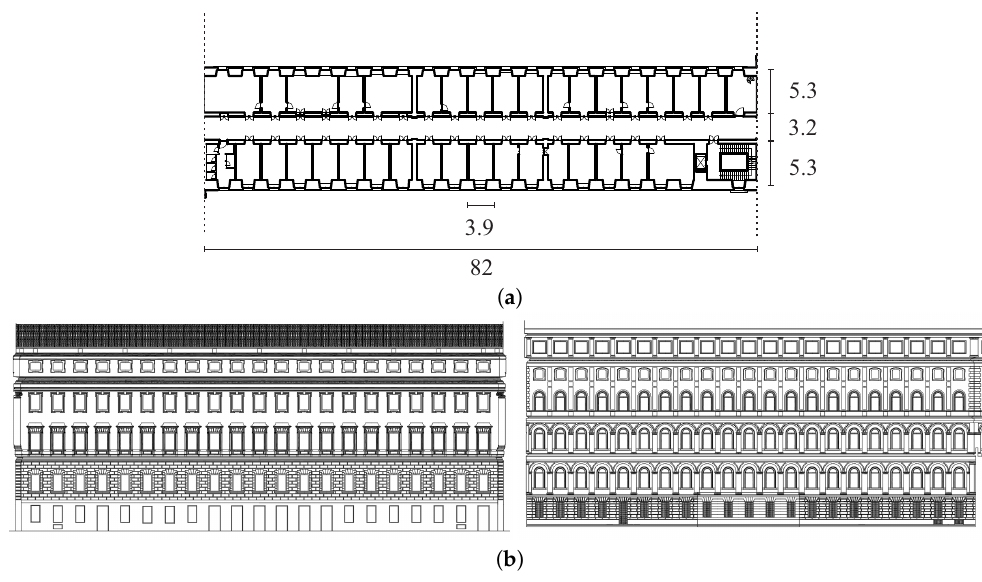
Figure 2. Long longitudinal arm details: ( a ) plan of the first floor; ( b ) perspectives of the two external facades. All the units are in